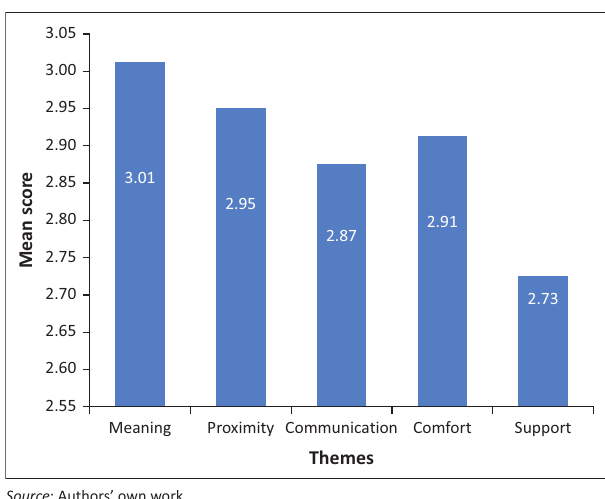
FIGURE 2: Overview of results for themes of CCFNI-2 (level of satisfaction of needs met).